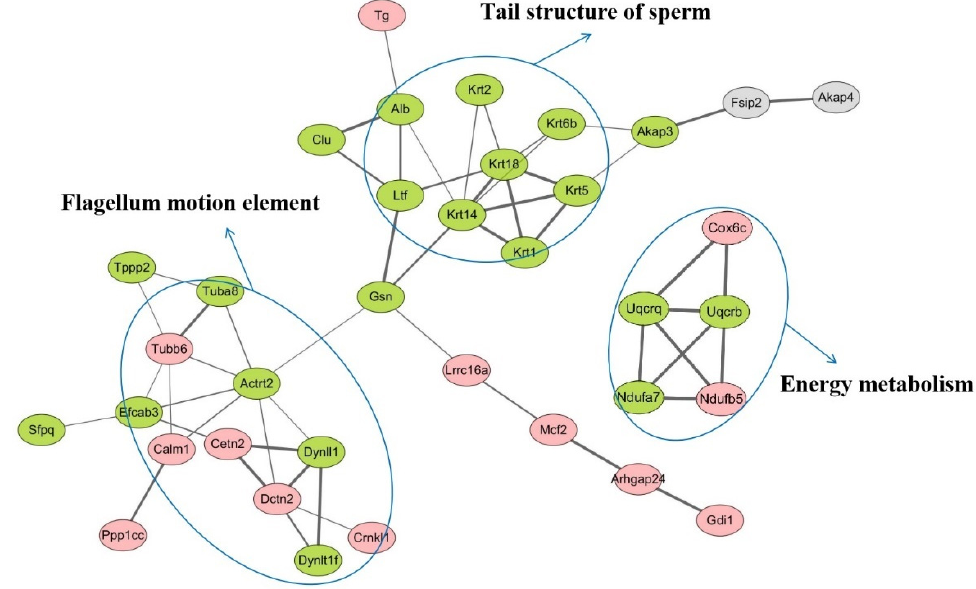
Figure 5. The protein–protein interaction network analysis of DEPs. Note: Only proteins with known interactions were listed. The red and green nodes represent upregulated and downregulated proteins, respectively.